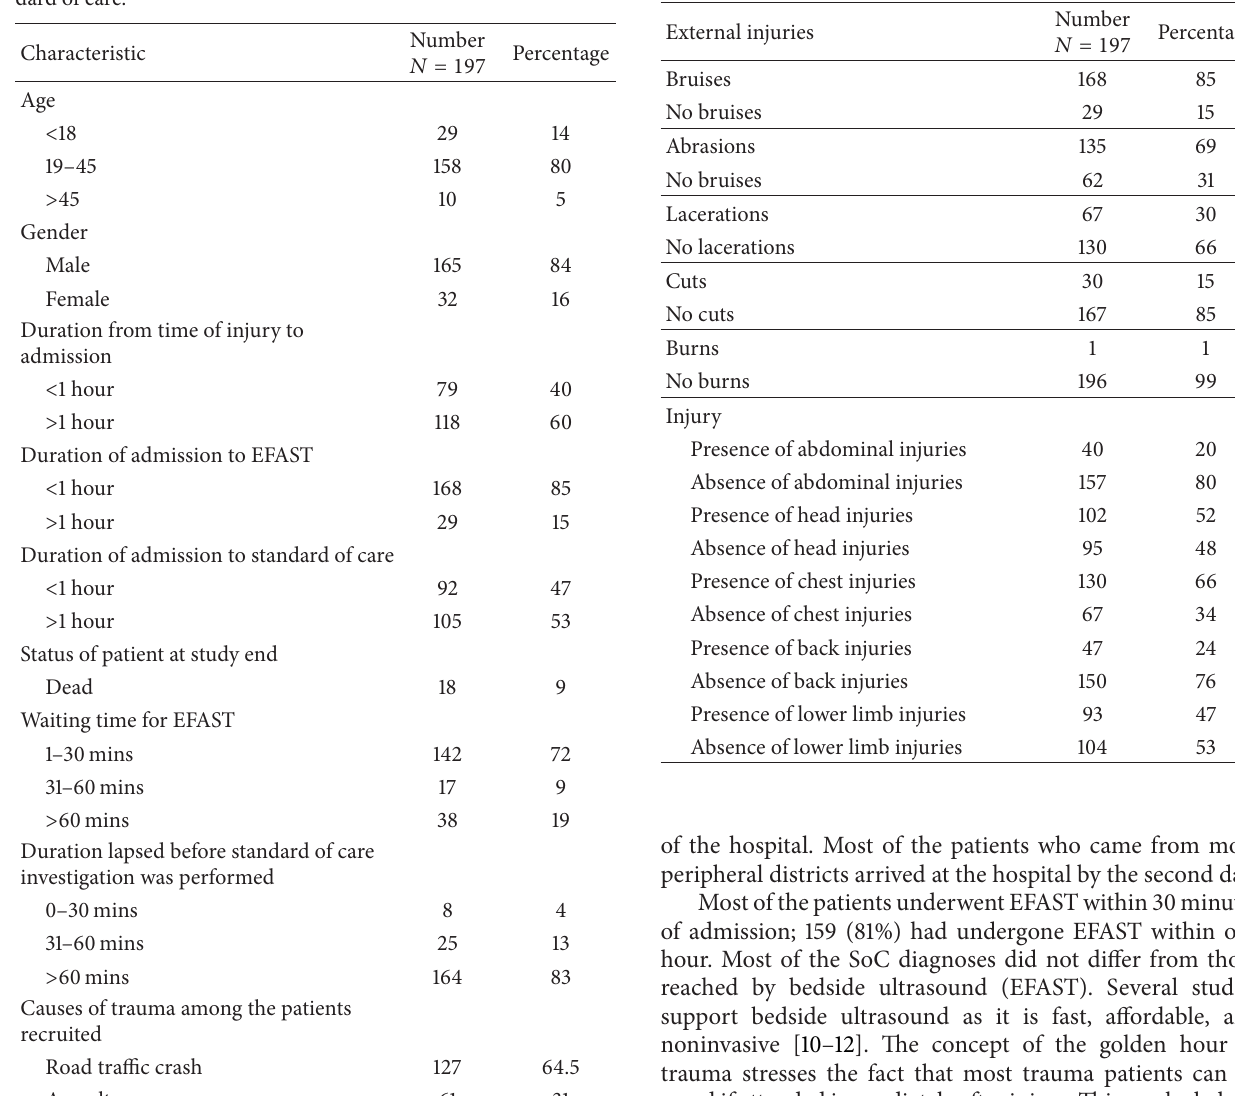
Table 2: Distribution of external